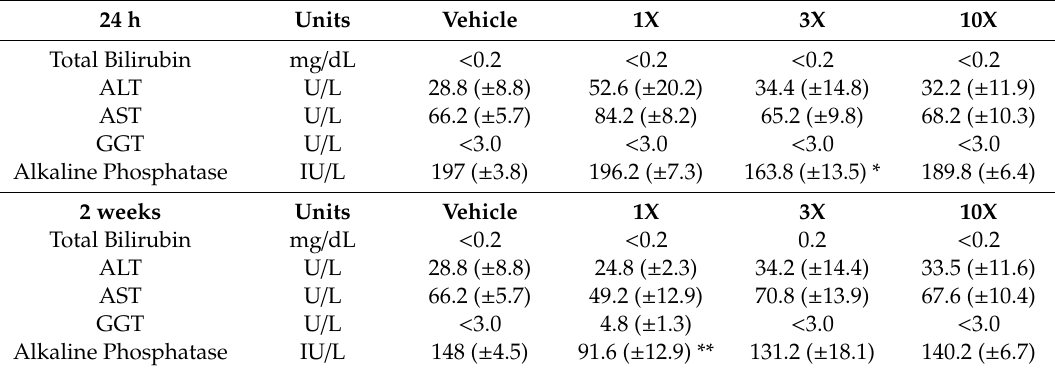
Figure 1. Analysis of dGTE acute toxicity. Body weights ( A ) and liver ‐ to ‐ body weight ratio ( B ). Photomicrograph of intact mouse liver after a single gavage with 10X mouse equivalent dose (MED) of dGTE ( C ). Total glutathione ( D ). mRNA levels of Lss and Chrebp genes (E). * p < 0.05, ** p < 0.01, *** p < 0.001; mean +/ ‐ SEM ( n = 5 per group). Table 2. Clinical chemistry parameters after dosing with dGTE for 24 h and 2 weeks.